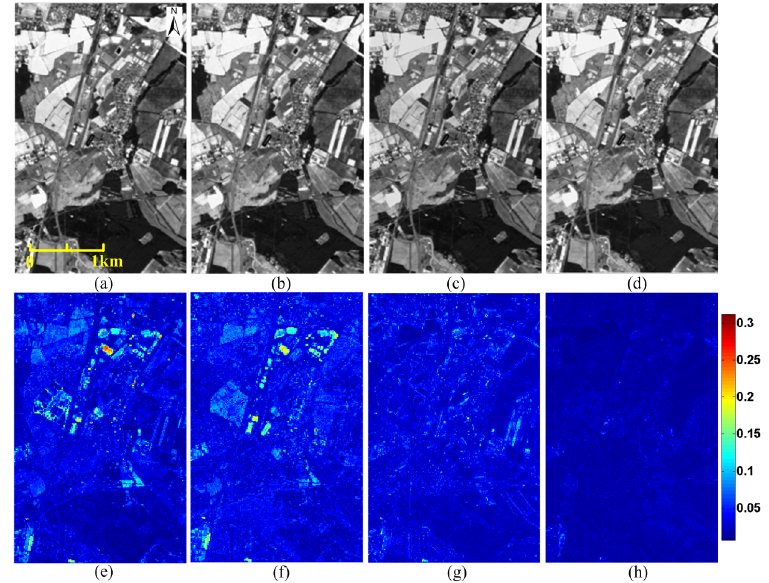
Figure 8. Reconstructed image (band 200) and root mean square error (RMSE) maps of different fusion results by a factor of two. The testing image is cropped from Berlin of EnMAP data with size 256 × 160. ( a ) result of SSR [12]; ( b ) result of BayesSR [13]; ( c ) result of CNMF [6]; ( d ) result of Two-CNN-Fu; ( e ) RMSE map of SSR [12]; ( f ) RMSE map of BayesSR [13]; ( g ) RMSE map of CNMF [6]; ( h ) RMSE map of Two-CNN-Fu.